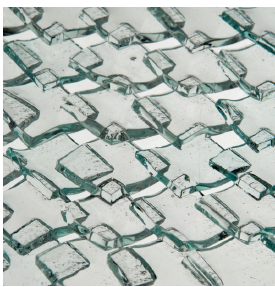
Figure 4: Fused glass shards – irregular arrangement, long heat